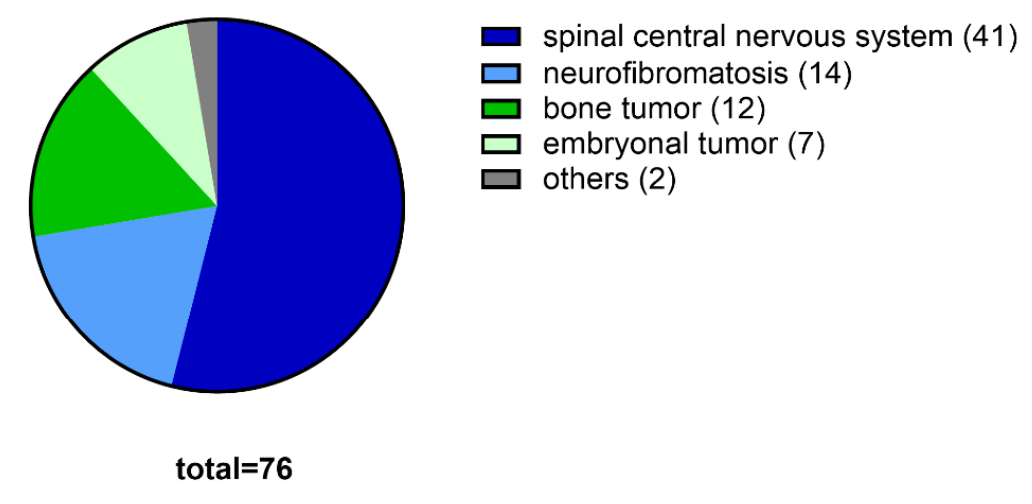
Figure 1. Tumor entities of the studied pediatric population ( n = 76).